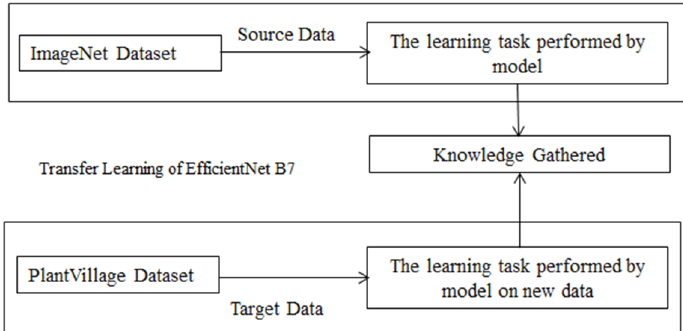
Figure 6. Re-training of proposed model.